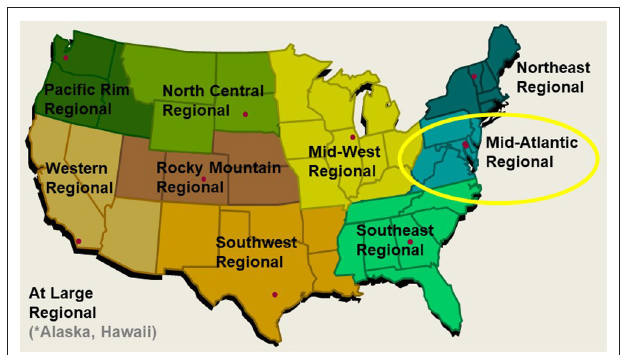
FIGURE 1 | The 10-region National Collegiate Cyber Defense Competition with Mid-Atlantic Region